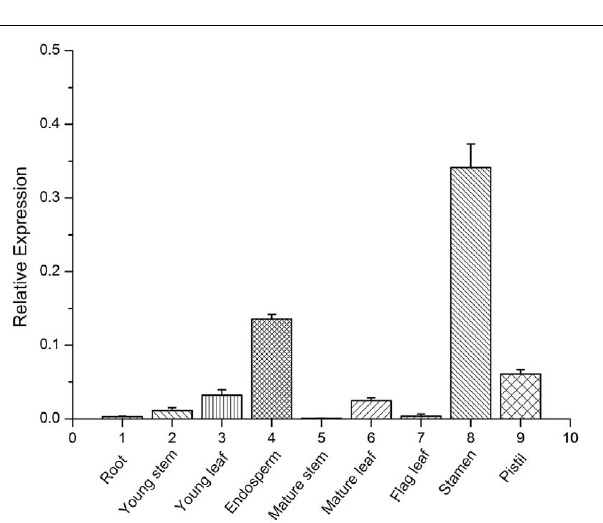
FIGURE 3 | Organ-specific expression assay of TaFUSCA3 in wheat by real-time qRT-PCR. The organs include roots, young stems, young leaves, endosperms, mature stems, mature leaves, flag leaves, stamens, and pistils. Data are means ± SD ( n = 3) in the organ-specific expression assays. Three biological experiments showed the same